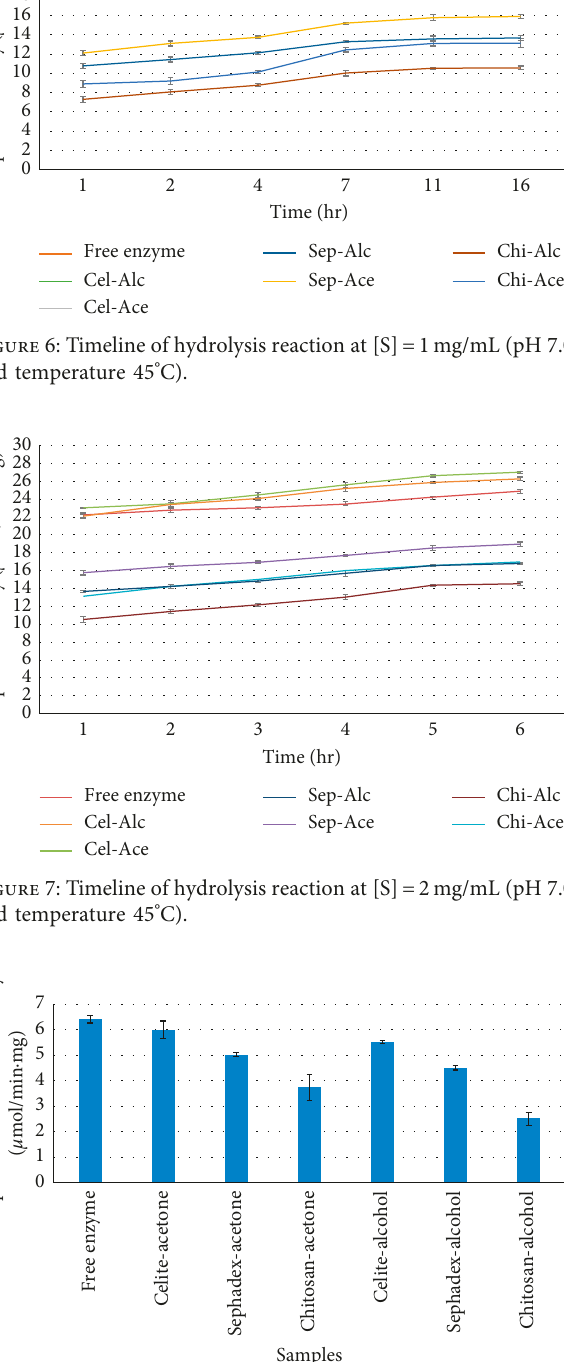
Figure 8: Specific esterification activities of all enzymes (pH 7.0, temperature 40 ° C, and time 12 hours).